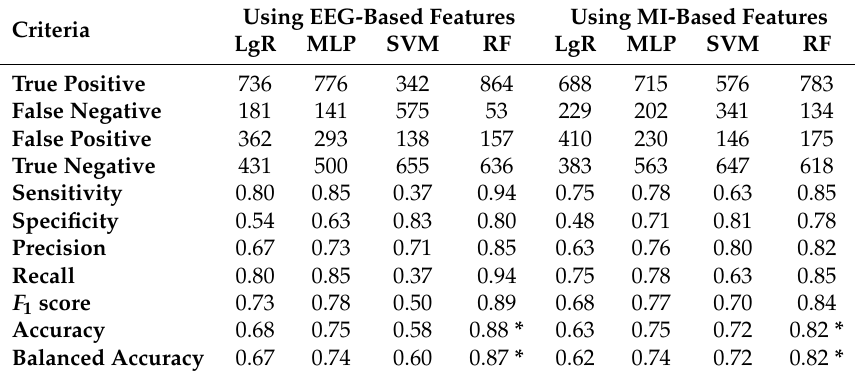
Table 7. Performance summary of classifying Low and High MWL with LgR, MLP, SVM and RF classifier models using EEG and MI-based feature on the holdout test set. In this task, the total number of observations was 1710, where low MWL was considered as the positive class. The number of observations with positive and negative class were 917 and 793, respectively. The highest accuracies obtained by using different feature sets are marked with ( *